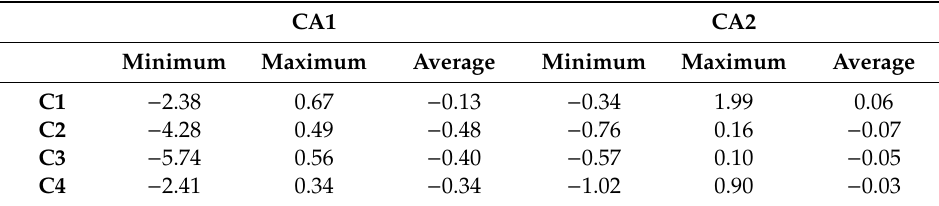
Table 4. Statistics of the chloro-alcaline indices.